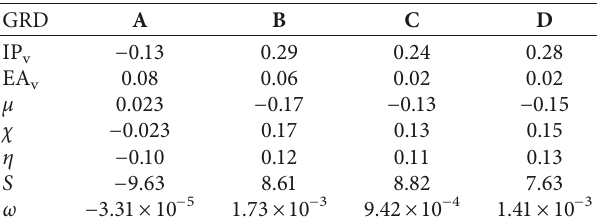
Table 5: Global reactivity descriptors (GRD) of the complexes investigated in eV and eV − 1 for global softness, calculated at M06/ma-def2-TZVP level of theory for the metal ions and M06/ma-def2-SVP level of theory for every other element, in the gas